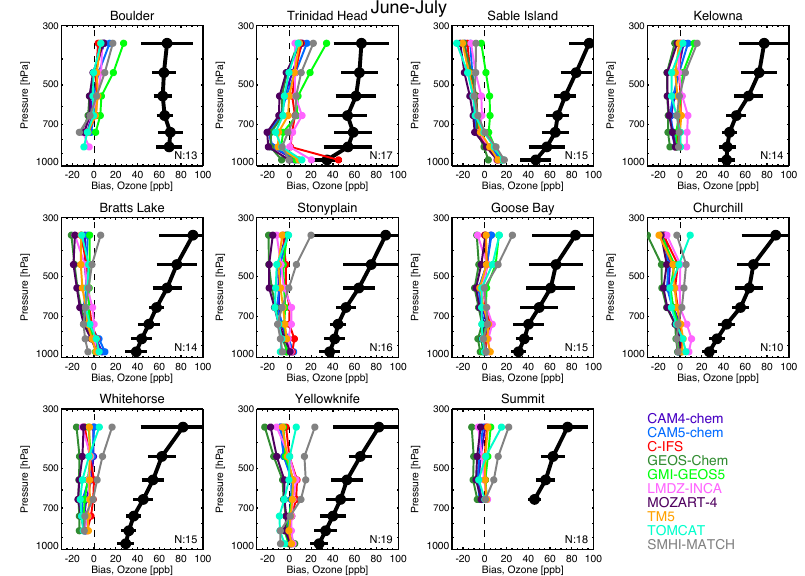
Figure 10. As Fig. 9, but for